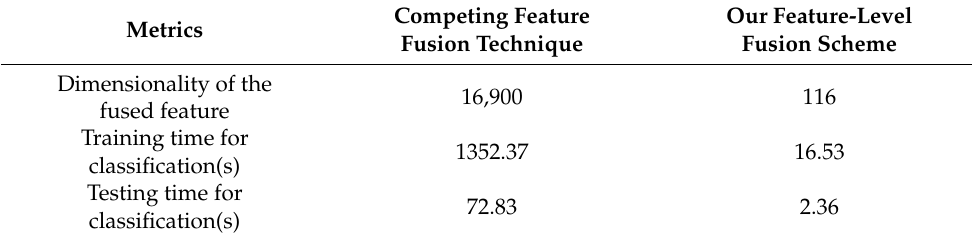
Table 8. Evaluation of feature-level fusion module on